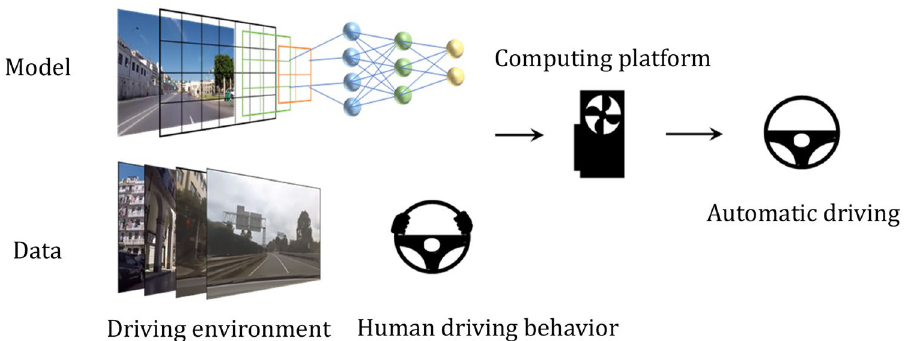
Figure 1. End-to-end autonomous driving learning mode. In the training process, the environmental information collected by the camera and other sensors is used as the input of the end-to-end agent of automatic driving model, and the driver’s decisions (throttle, steering wheel angle, deceleration braking, etc.) are used as the training labels so that the end-to-end autonomous driving system can finally learn to output reasonable control decisions based on the surrounding scene